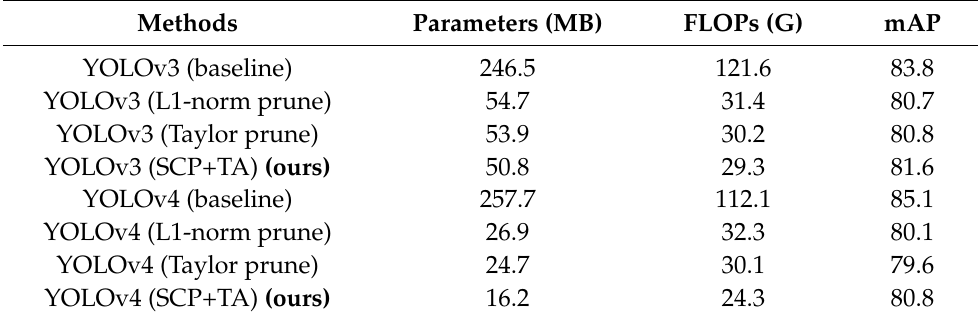
Table 5. Comparisons with different pruning methods on NWPU